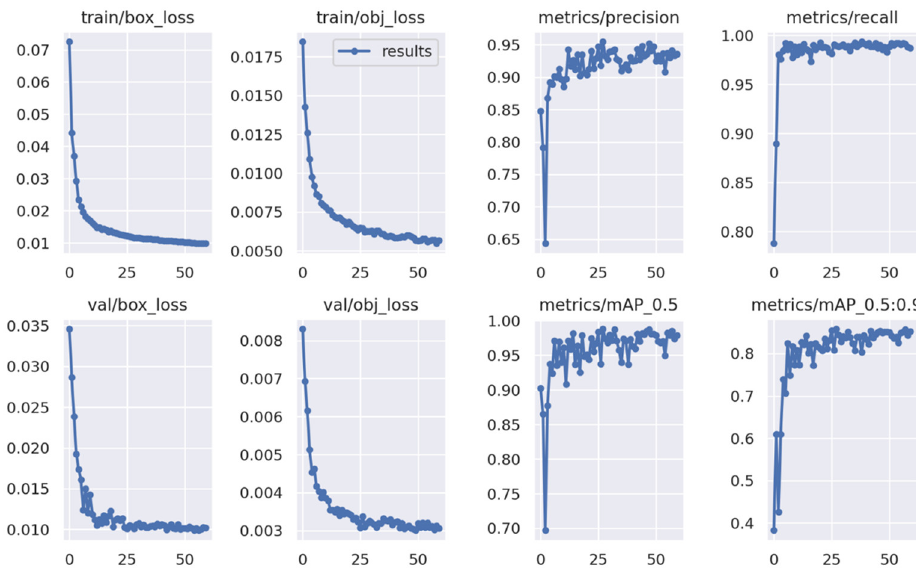
Figure 14. Training results from YOLOv5.